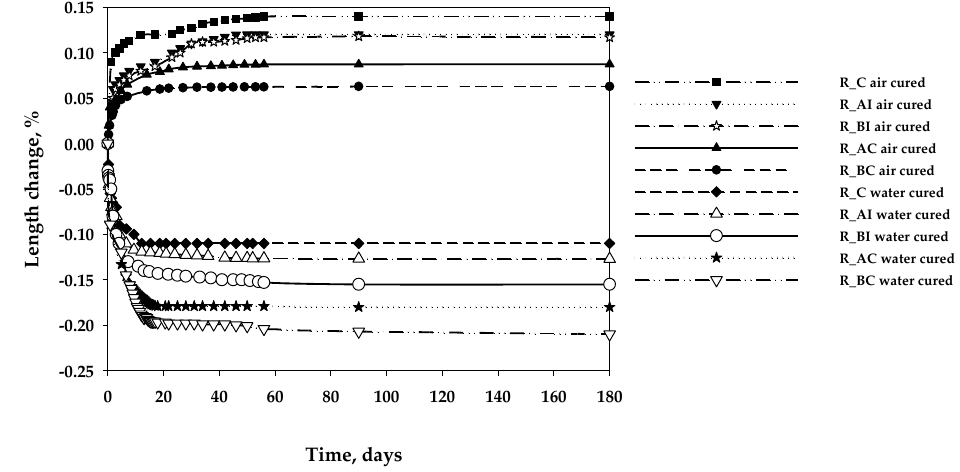
Figure 11. DMS curves for CSA-based pastes (air- and water-cured).